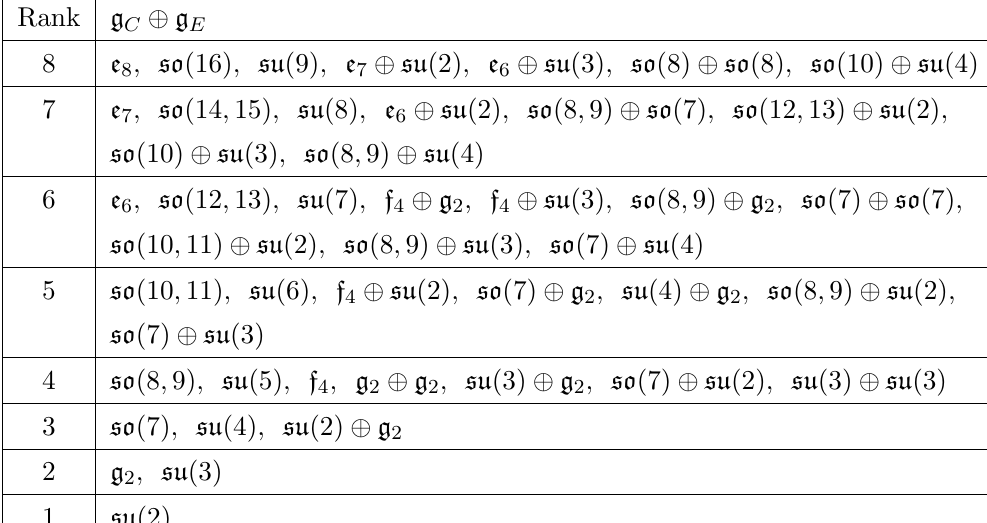
Table 2 . Possible gauge algebras that can surround a